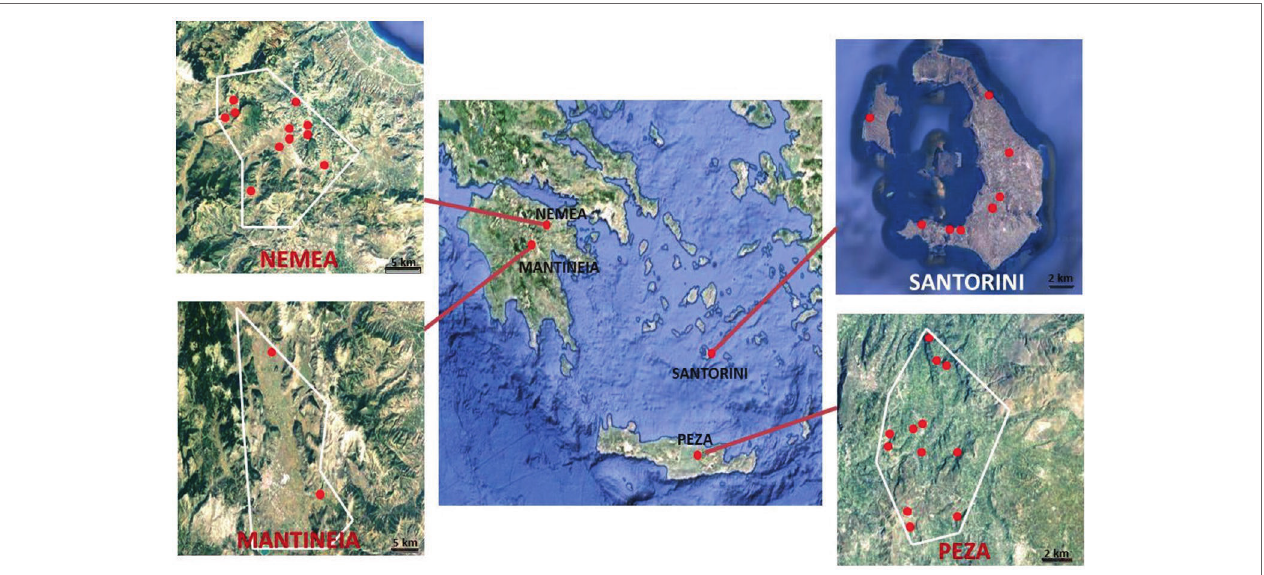
FIGURE 1 | Maps of the vineyards sampled in four major PDO regions in Greece (Nemea and Mantineia in Peloponnese, Santorini island, and Peza in Crete). Images taken from Google Maps © 2021 TerraMetrics, Map data © 2021